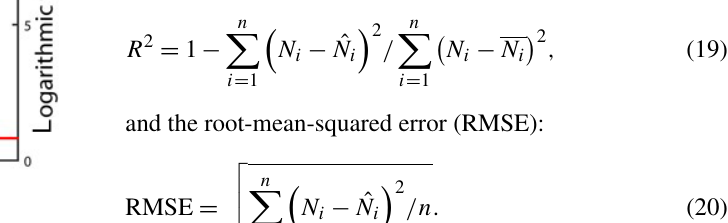
Figure 5. Within-class variance σ B 2 in the negentropy (red line) and negentropy